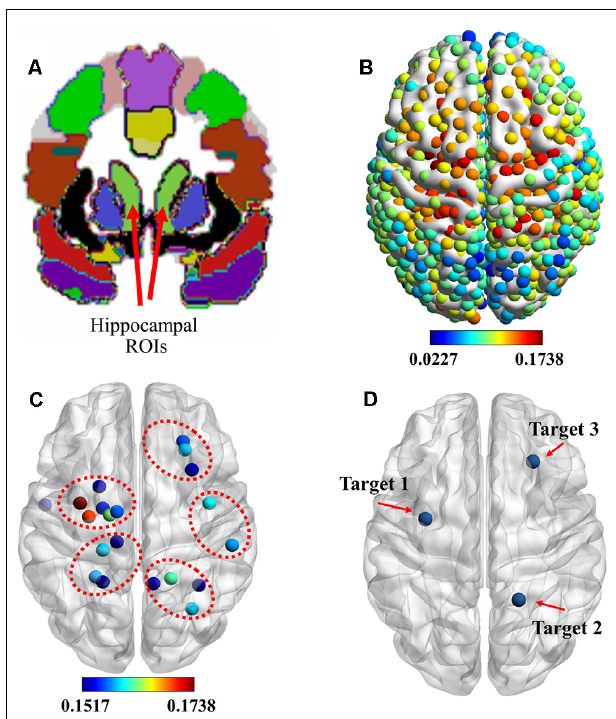
FIGURE 2 | Identification of stimulation targets. (A) Two light-green hippocampal regions of interest (ROIs) selected from the automated anatomical labeling (AAL) template in the Montreal Neurological Institute (MNI) space. (B) ROIs showing the functional magnetic resonance imaging (fMRI) connectivity of the cortex with the hippocampal ROI. (C) Top 20 ROIs showing the fMRI connectivity of the cortex with the hippocampus. (D) Three stimulation targets were located based on the maximum fMRI connectivity of the cortex with the hippocampus from the whole cerebral cortical, lateral parietal cortical, and medial prefrontal cortical areas. rTMS was delivered to these targets under the guidance of a neuronavigation system.